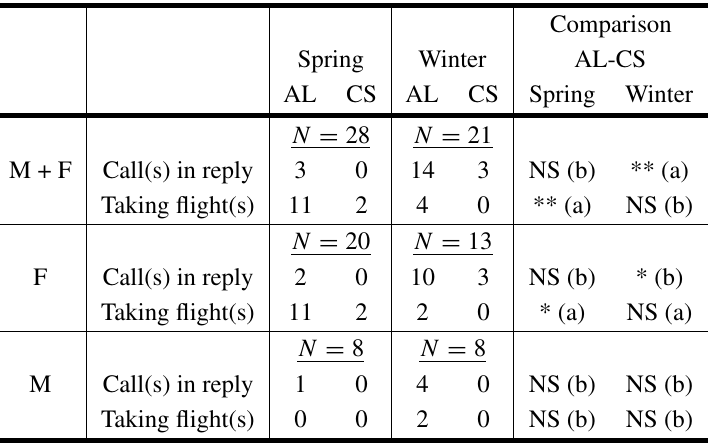
Sexual and seasonal distributions of the number of budgerigars responding by call(s) in reply or by taking